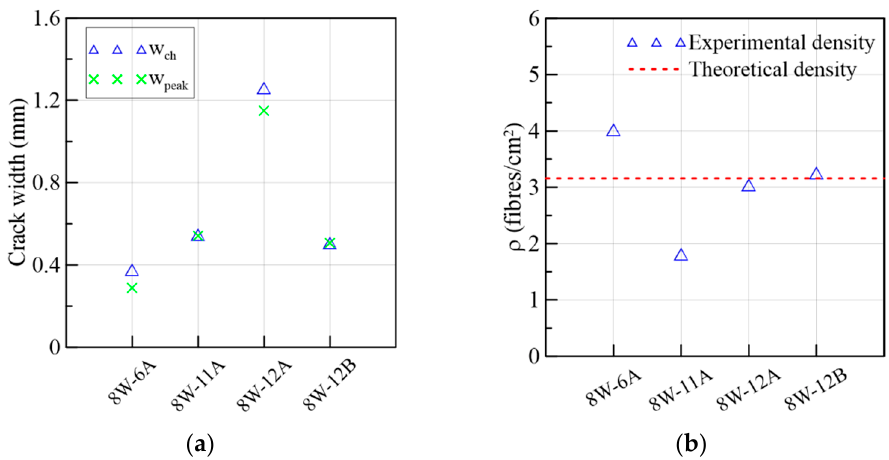
Figure 13. Mechanical results of 8W specimens: ( a ) crack widths at change in behavior and at peak load and ( b ) fiber densities. load and ( b ) fiber